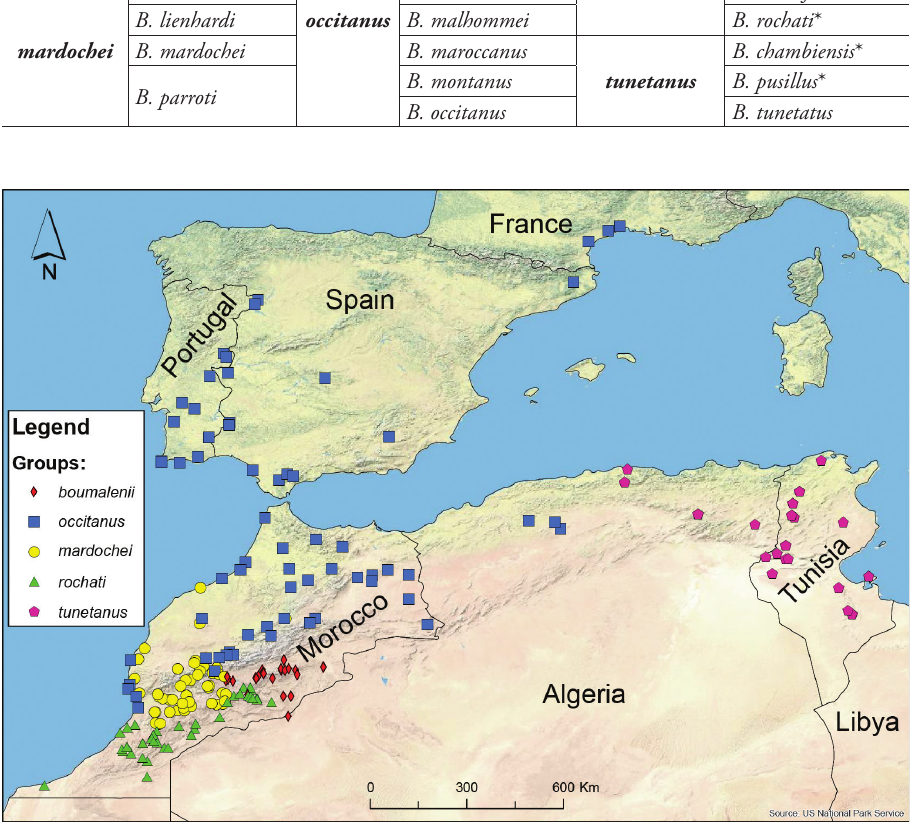
Figure 7. Map representing the five phylogenetic Buthus cox1 groups in the Maghreb. Groups as defined by Sousa et al. (2012) and Pedroso et al. (2013), also including cox1 sequences from Gantenbein and Largiadèr (2003), Habel et al. (2012) and Husemann et al. (2012) (redrawing of Figure 1 from Pedroso et al.